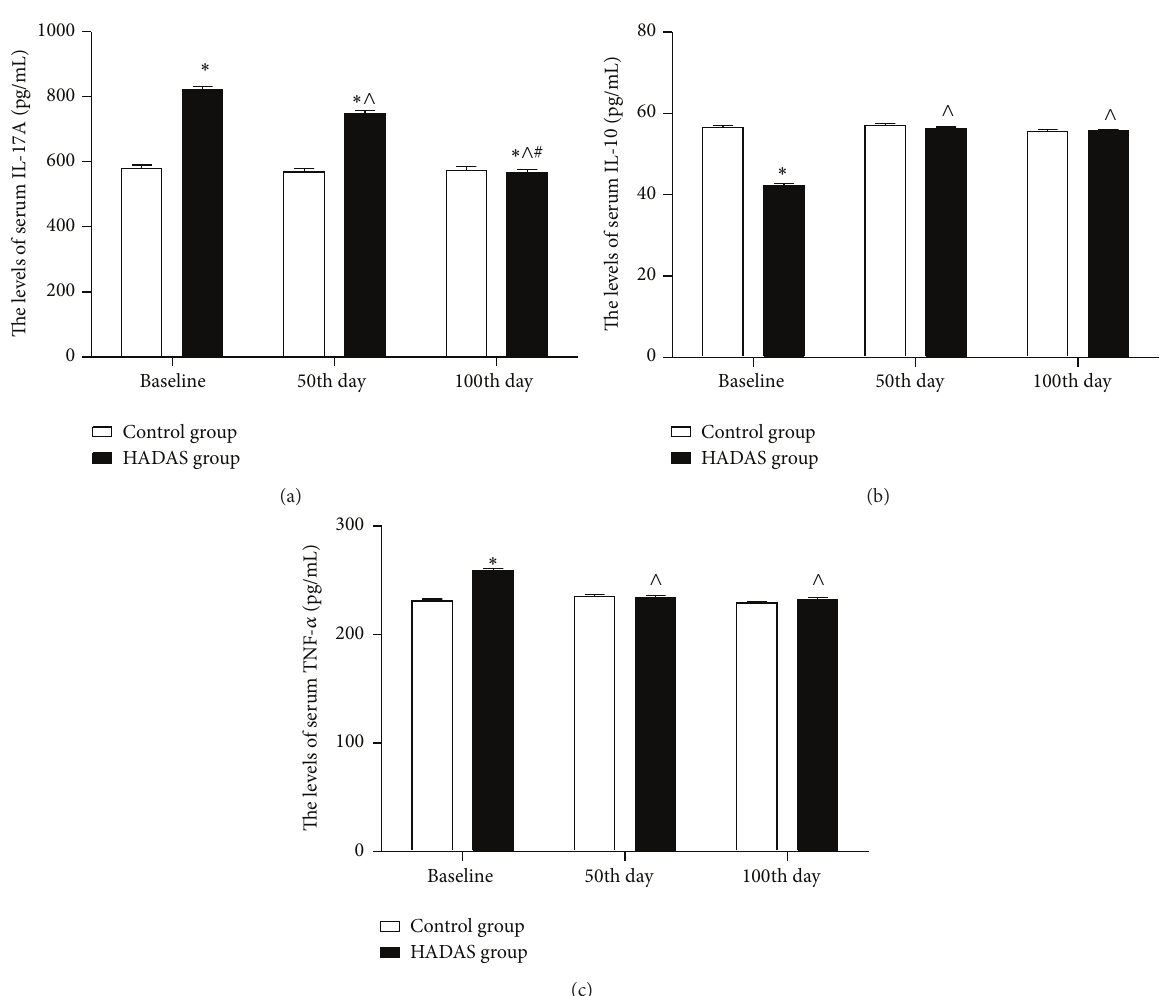
Figure 2: The serum SOD and MDA levels of subjects between HADAS and control groups. Data are presented as mean ± SE. SOD = superoxide dismutase; MDA = malondialdehyde. The serum SOD (a) and MDA (b) of subjects in both groups were assayed at baseline, 50th day, and 100 day. ∗ 𝑝 < 0.05 , relative to control group; ∧ 𝑝 < 0.05 , relative to baseline.